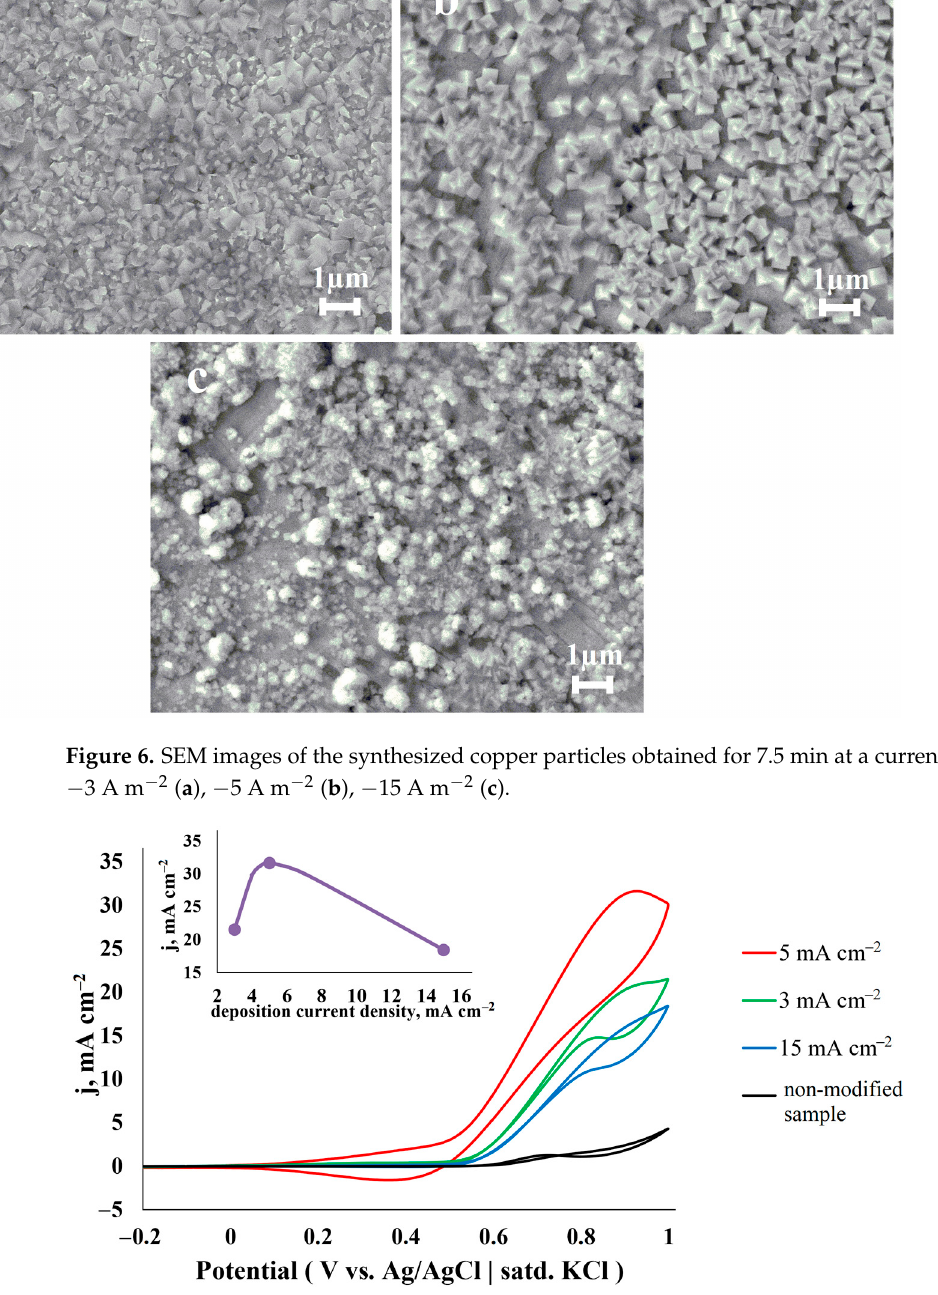
Figure 7. CV of copper catalysts obtained for 7.5 min and a KBr concentration of 1 g L − 1 at a deposition current of − 3, − 5, and − 15 A m − 2 . Inset: plot of anodic peak current versus copper deposition current density.